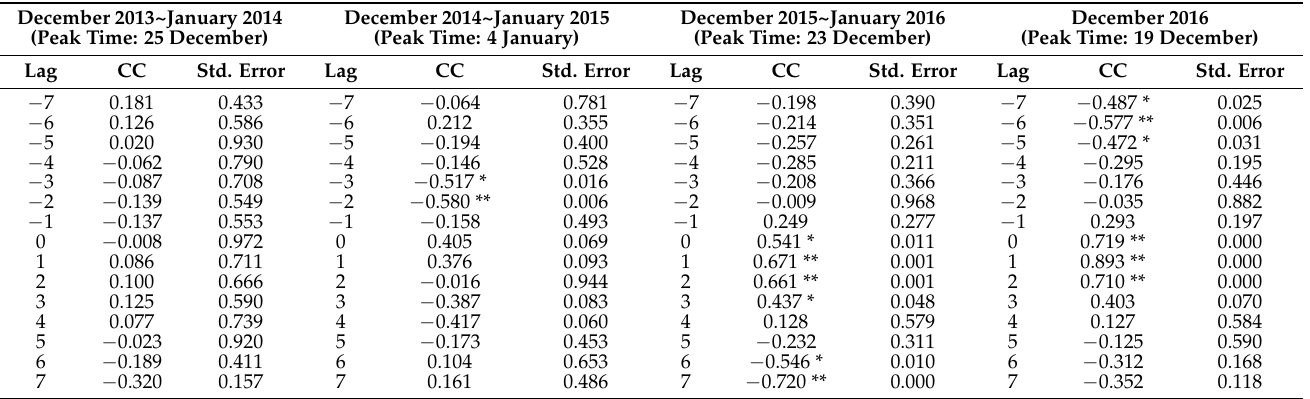
Table 1. Lag correlation coefficient between public concern and PM 2.5 concentration for different haze pollution peaks.